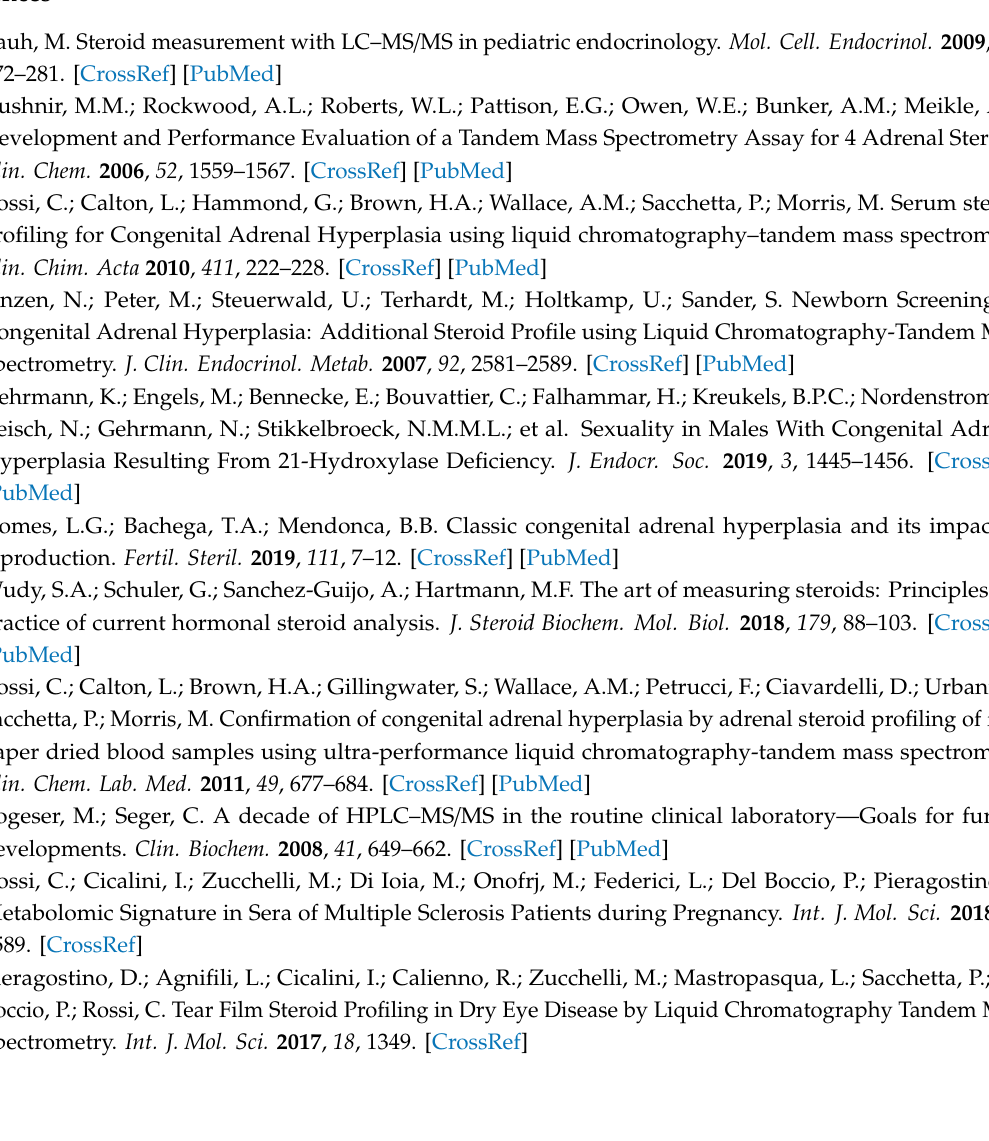
Table S1: Concentration levels (ng / mL) for calibrators and QC materials of each steroid monitored in the LC–MS / MS method of analysis are summarized. Table S2: MS / MS operating conditions. Multiple reaction monitoring (MRM) functions and settings for detection of steroids are shown. Italics denotes qualifier ion. Table S3: Table shows CV% of calibrator levels at low (L1), medium (L4), and high (L7) concentrations, as well as the R 2 related to the linear regression for each steroid monitored in the LC–MS / MS method. Figure S1: Multiple reaction monitoring (MRM) chromatogram of calibration level L7, which depicts the quantifying transitions for CORT, CCONE, 11-DECOL, ADIONE, TESTO, 17-OHP, and PROG. Figure S2: The linear regression calculated using the instrumental response (y axis) vs. the concentration in ng / mL (x axis) of the calibrator levels, for the evaluation of the method linearity and for the samples